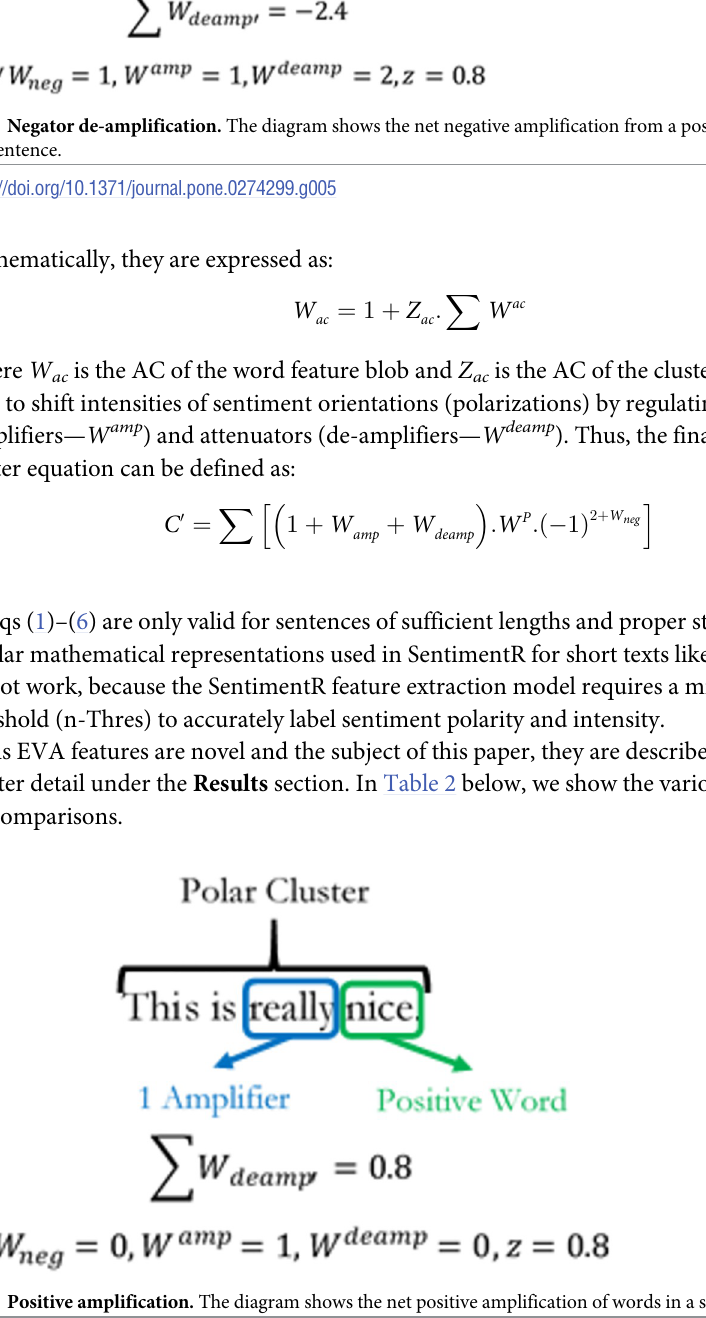
Fig 6. Positive amplification. The diagram shows the net positive amplification of words in a sentence.